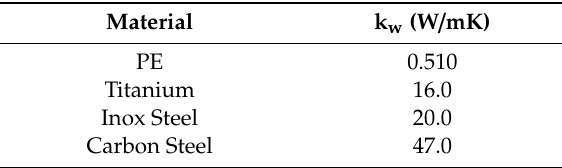
Table 5. Thermal Conductivity of simulated